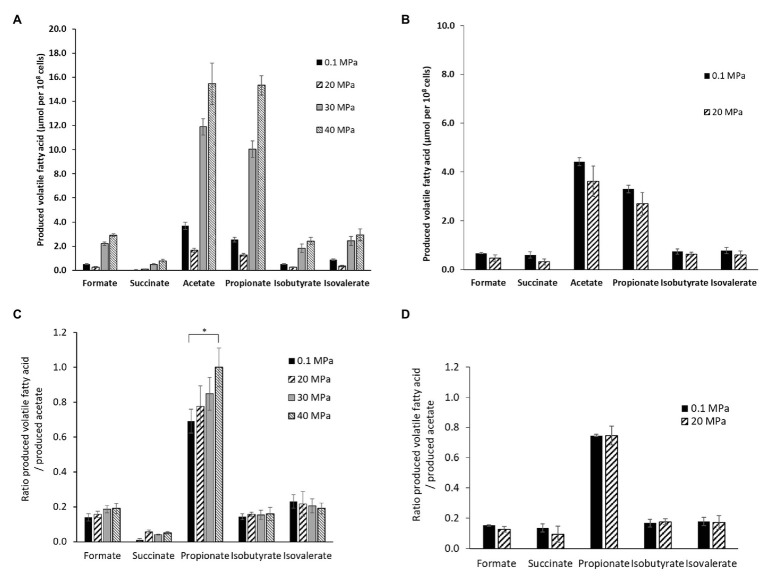
Volatile fatty acids (FAs) production by P. elfii DSM9442 (A), and P. elfii subsp. lettingae
(B), expressed as μmol per 108 cells and ratios of produced volatile FAs related to the amount of acetate produced by P. elfii DSM9442 (C), and P. elfii subsp. lettingae
(D) when grown at various hydrostatic pressures. Significant increase in the produced-propionate to produced acetate ratio between 0.1 and 40 MPa is marked with one asterisk (p = 0.003, α = 0.01, Kruskal-Wallis test).